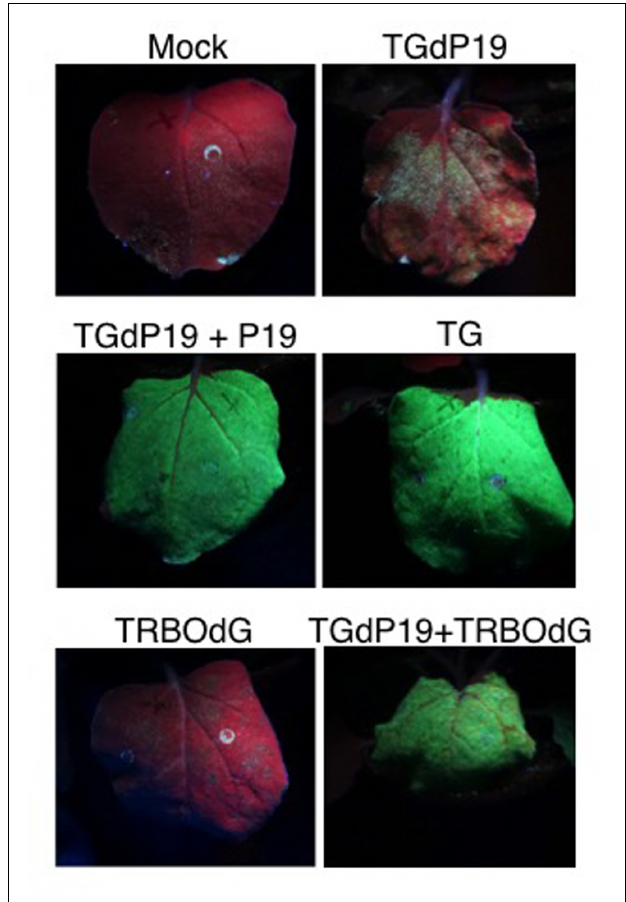
FIGURE 6 | Co-infiltration of TGdP19 (TG not expressing P19) with TRBOdG (TRBO not expressing GFP) on N. benthamiana . Images were taken at 6 dpi. Top panels show infiltrated leaves for Mock and TGdP19; middle panels TGdP19+P19 and TG; and lower panels TRBOdG and